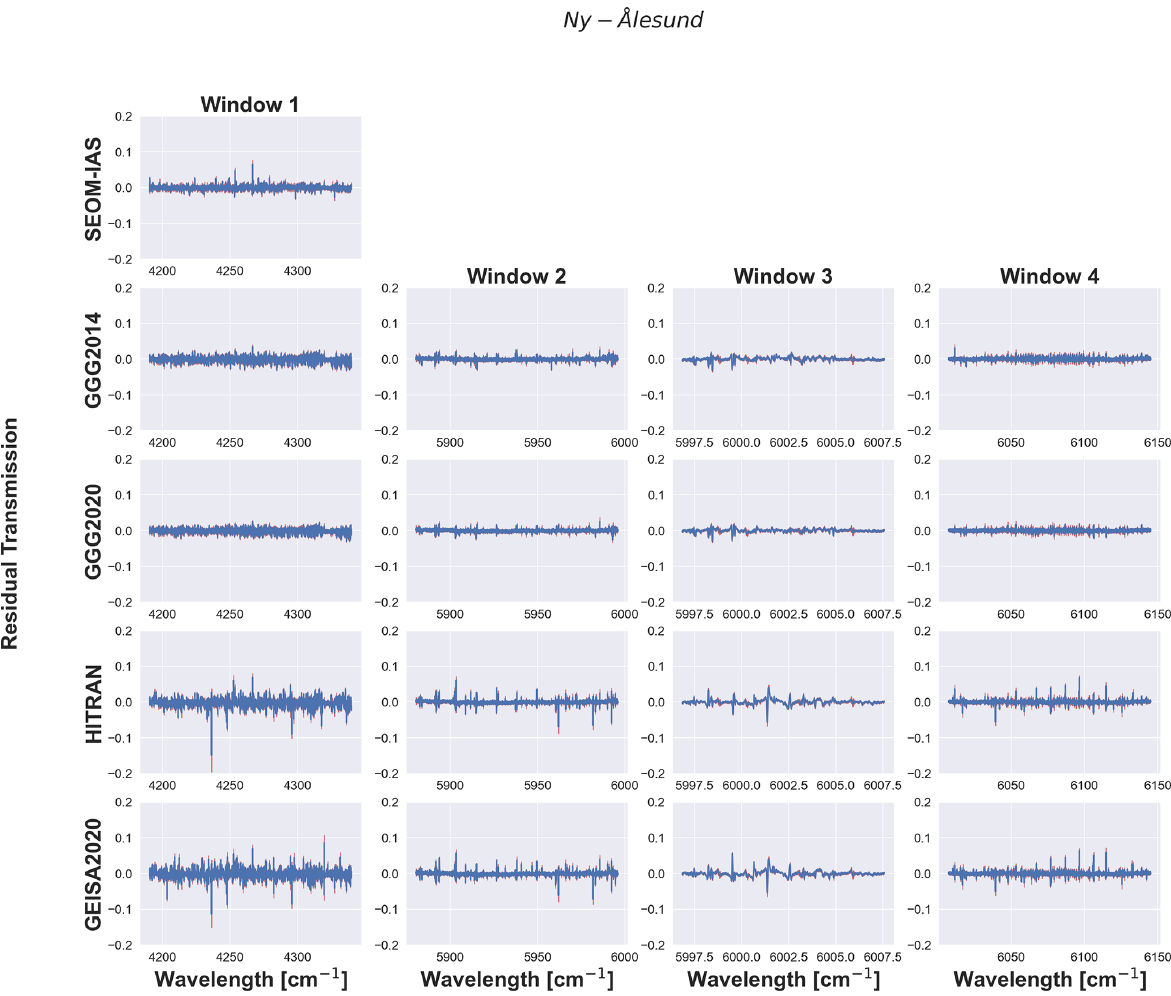
Figure 1. Example residual transmission spectra calculated from measured and fitted spectra from the Ny-Ålesund in 2019. The blue line indicates an example of the fit residual between the calculated transmission and the measured transmission. The red line indicates the standard deviation of the residual, based on all spectra taken over the entire dataset. The columns of this figure identify the residuals of a specific window and the rows a specific database, as identified in the axis